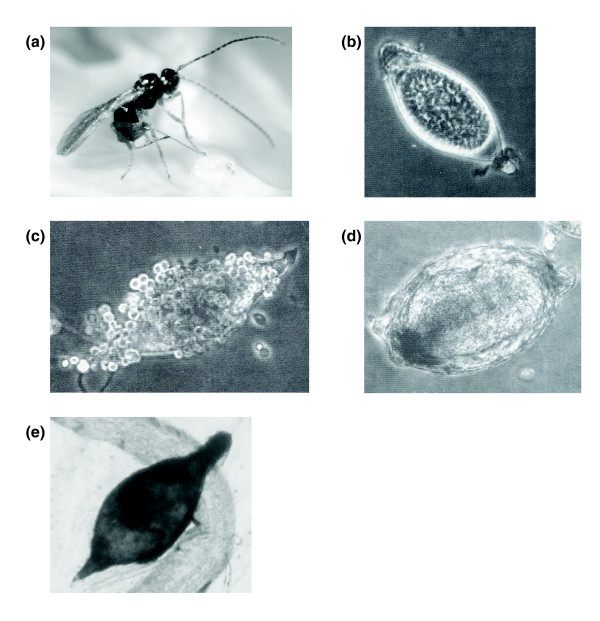
The Drosophila immune response after attack by parasitoids. (a) The parasitoid Asobara tabida stabs a second instar Drosophila melanogaster larvae with her ovipositor and inserts a single egg. (b) The parasitoid egg is susceptible to nonself recognition by membrane-bound and noncellular pattern recognition proteins in the larval hemolymph. (c) Hemocyte proliferation and differentiation is triggered, and the blood cells aggregate around the parasitoid egg. (d) The hemocytes form a multilayered capsule around the parasitoid egg and melanin is deposited on the capsule. (e) The parasitoid egg dies when it becomes fully melanized.